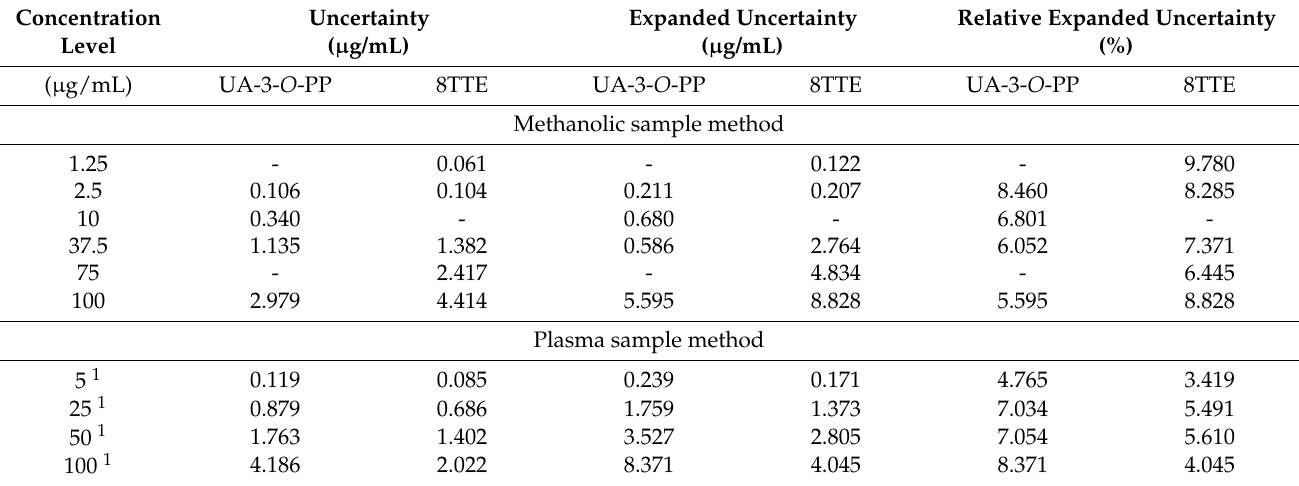
Table 3. Validation results obtained for the quantification method of UA-3- O -PP and 8TTE in MeOH.